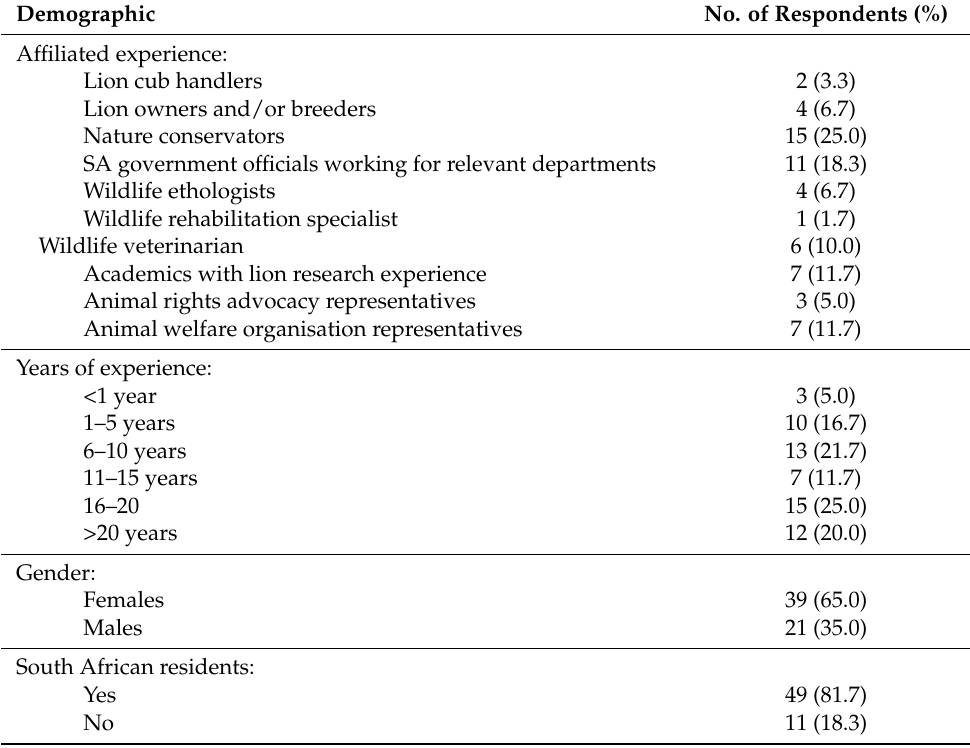
Table 2. Demographics of the online adaptive conjoint analysis survey participants ( n = 60).